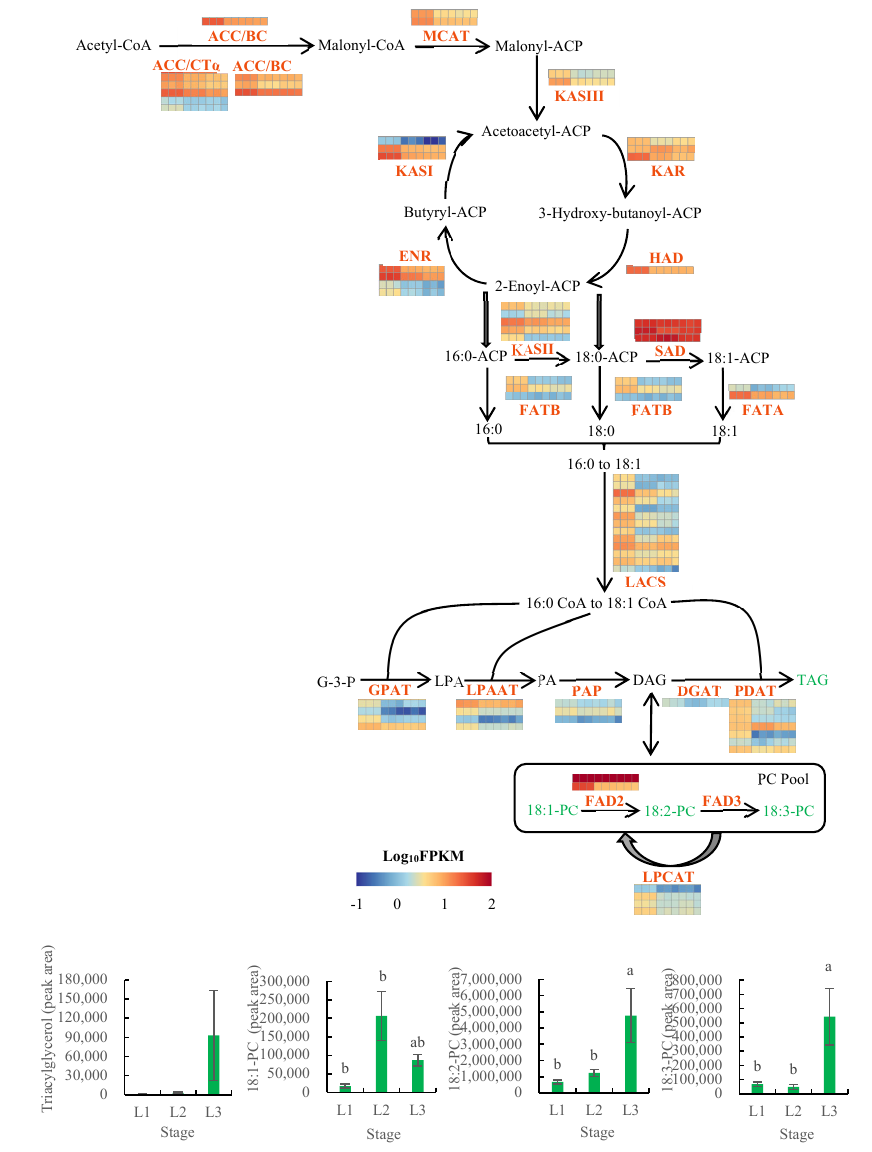
Figure 6. Analysis of lipid biosynthesis genes and metabolites in walnut embryos. Note: the expression values of genes are shown in the thermal map, which displays the homogenization values of genes. Red and blue indicate higher and lower abundances, respectively. L1 was 60 DAP, L2 was 90 DAP, and L3 was 120 DAP. The nine squares in each horizontal row correspond to the nine samples (L1_1, L1_2, L1_3, L2_1, L2_2, L2_3, L3_1, L3_2, and L3_3). The metabolite peak areas are shown in the cylindrical map. Bars represent the mean ± SE (n = 6). Bars with different lowercase letters (a and b) are significantly different ( p < 0.05). ACC/CT α , acetyl − CoA carboxyl transferase subunit alpha; ACC/BC, acetyl − CoA carboxylase biotin carboxylase subunit; ACC/BCCP, acetyl − CoA carboxylase biotin carboxyl carrier pro- tein; MCAT, malonyl CoA − acyl carrier protein transacylase; KASI, 3 − oxoacyl − ACP synthase I; KASII, 3 − oxoacyl − ACP synthase II; KASIII, 3 − oxoacyl − ACP synthase III; KAR, 3 − oxoacyl − ACP reductase; HAD, 3 − hydroxyacyl − ACP dehydratase; ENR, enoyl − ACP reductase; SAD, stearoyl − ACP-desaturase; FATA, fatty acyl − ACP thioesterase A; FATB, fatty acyl − ACP thioesterase B; LACS, long − chain acyl − CoA synthetase; GPAT, glycerol − 3 − phosphate acyltransferase; LPAAT, lysophosphatidic acid acyltransferase; PAP, phosphatidate phosphatase; PDAT, phospholipid:diacylglycerol acyltransferase; DGAT1, diacylglycerol acyltransferase 1; FAD2, fatty acid desaturase 2; FAD3, fatty acid desaturase 3; LPCAT, lysophospholipid acyltransferase; G − 3 − P, Glycerol − 3 − phosphate; LPA, 1 − acylglycerol − 3P; PA, 1,2 − diacylglycerol − 3P; DAG, 1,2 − diacylglycerol; TAG,